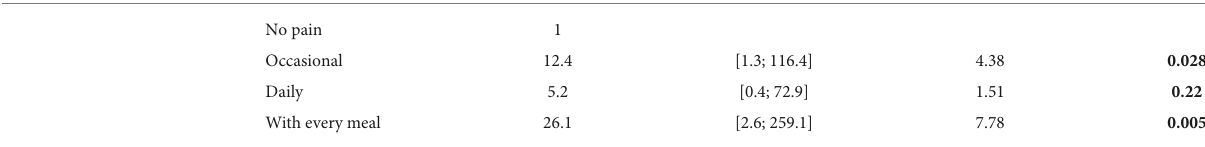
TABLE 3 Adjusted logistic regression analysis of occasional chest pain vs. no pain at 12 months after surgery associated with presurgical chest pain ( n = 66).